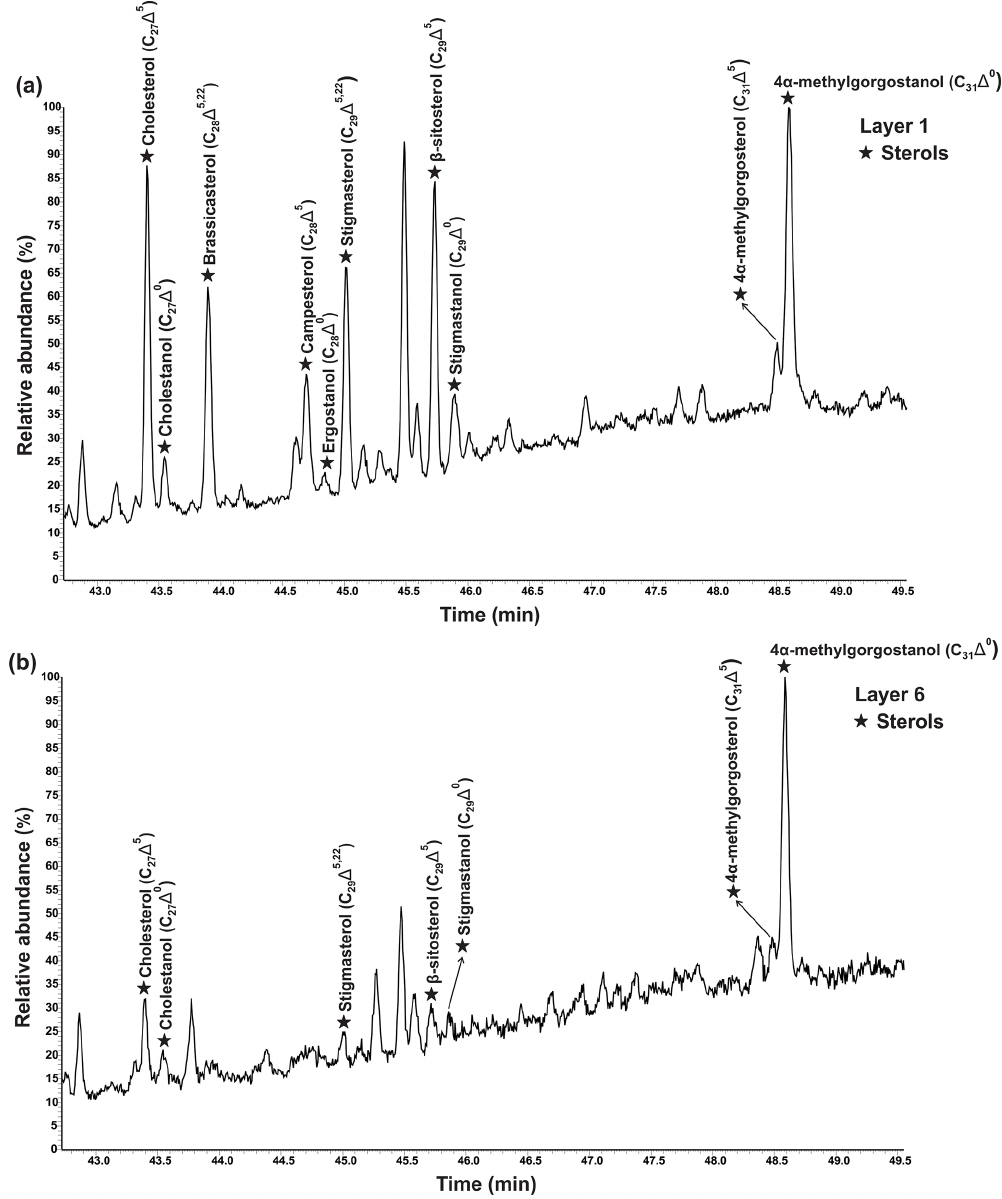
Figure 4. Partial GC–MS chromatograms (total ion current) show the distributions of freely extractable sterols (TMS derivatives) in (a) layer 1 and (b) layer 6 of the microbial